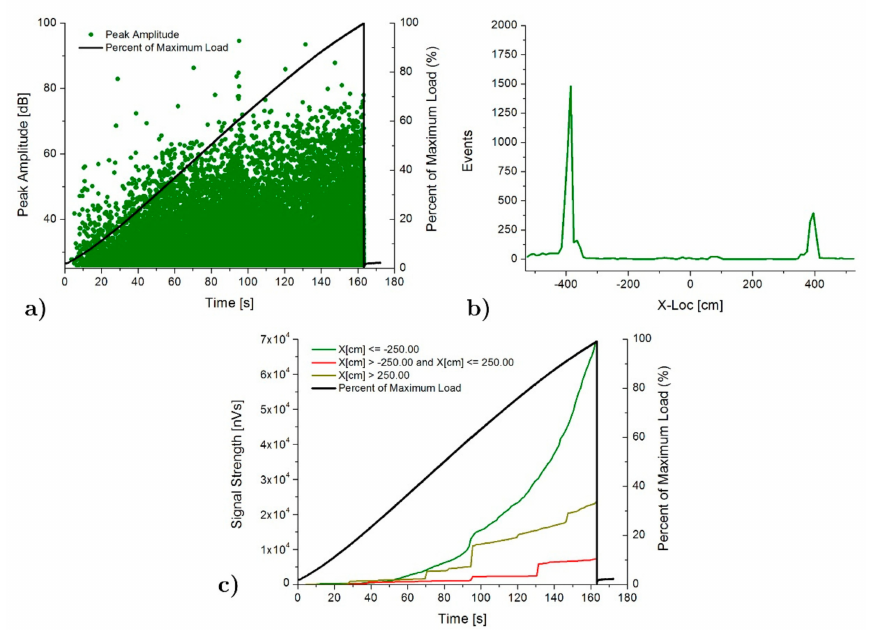
Figure 9. AE results for SP specimen: ( a ) Peak amplitude vs load history over the time, ( b ) Linear location over the specimen and ( c ) Signal strength vs load history over the